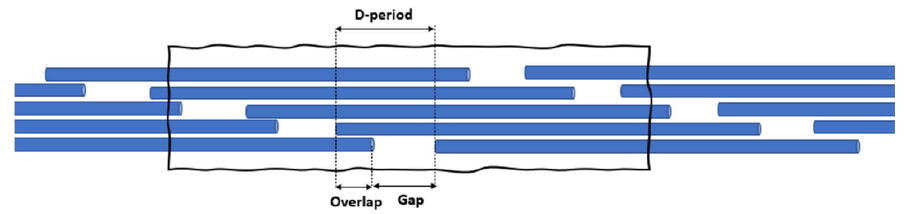
Figure 2. Collagen fibril Gap/Overlap structure.